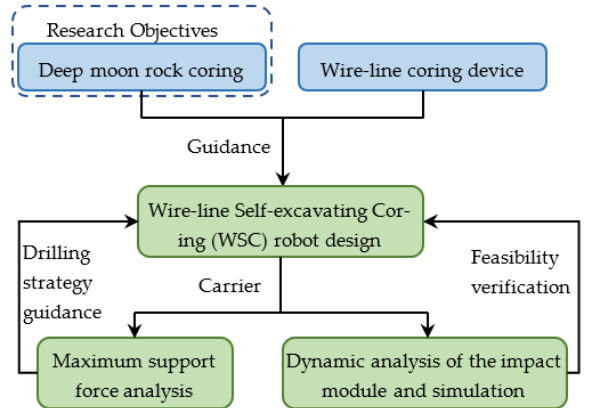
Figure 1. Methodological framework for the wire-line self-excavating coring robot research.